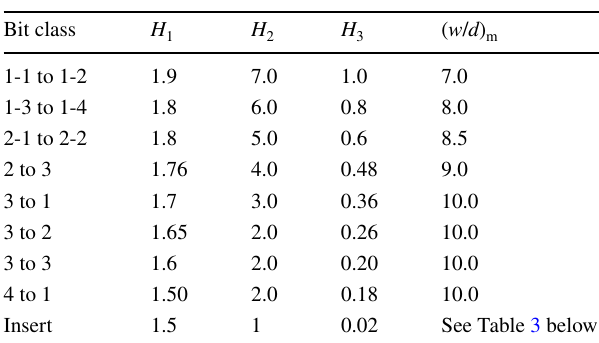
Table 2 Tooth wears parameters recommended by Bourgoyne and Young (Bourgoyne et al. 1986) Tooth wear parameters recommended by Bourgoyne and Young (8) Bit class